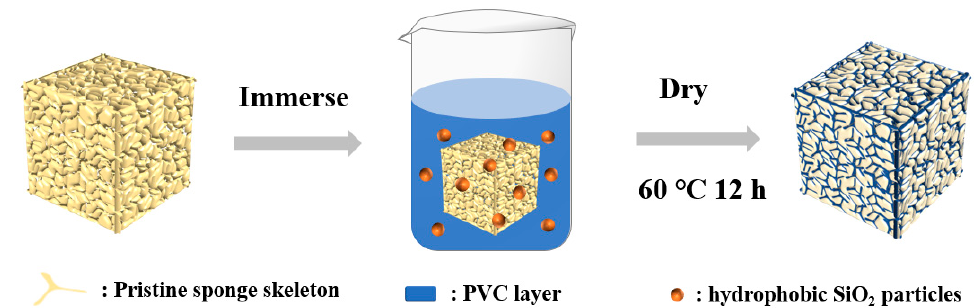
Figure 1. Schematic illustration for the fabrication of MS@PVC@SiO 2